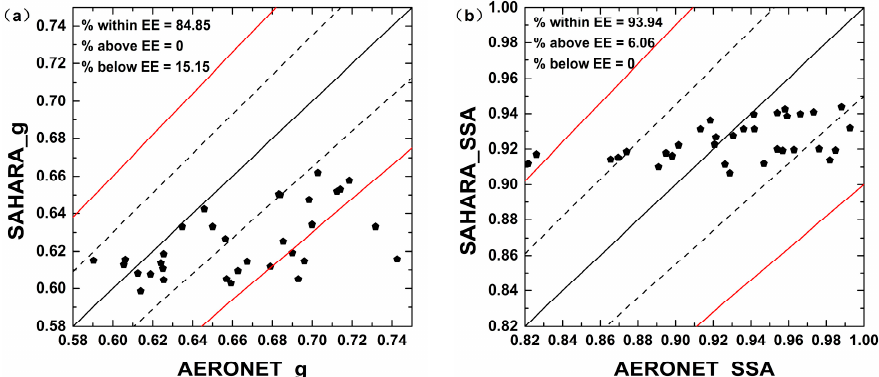
Figure 8. Comparison between SAHARA parameterization and Aerosol Robotic Network (AERONET) for asymmetry factor (g) ( a ) and single scattering albedo (SSA) ( b ). The red solid line indicates the 10% error envelope (EE) while the black dash and black dotted lines indicate the 1:1 line and 5% EE.